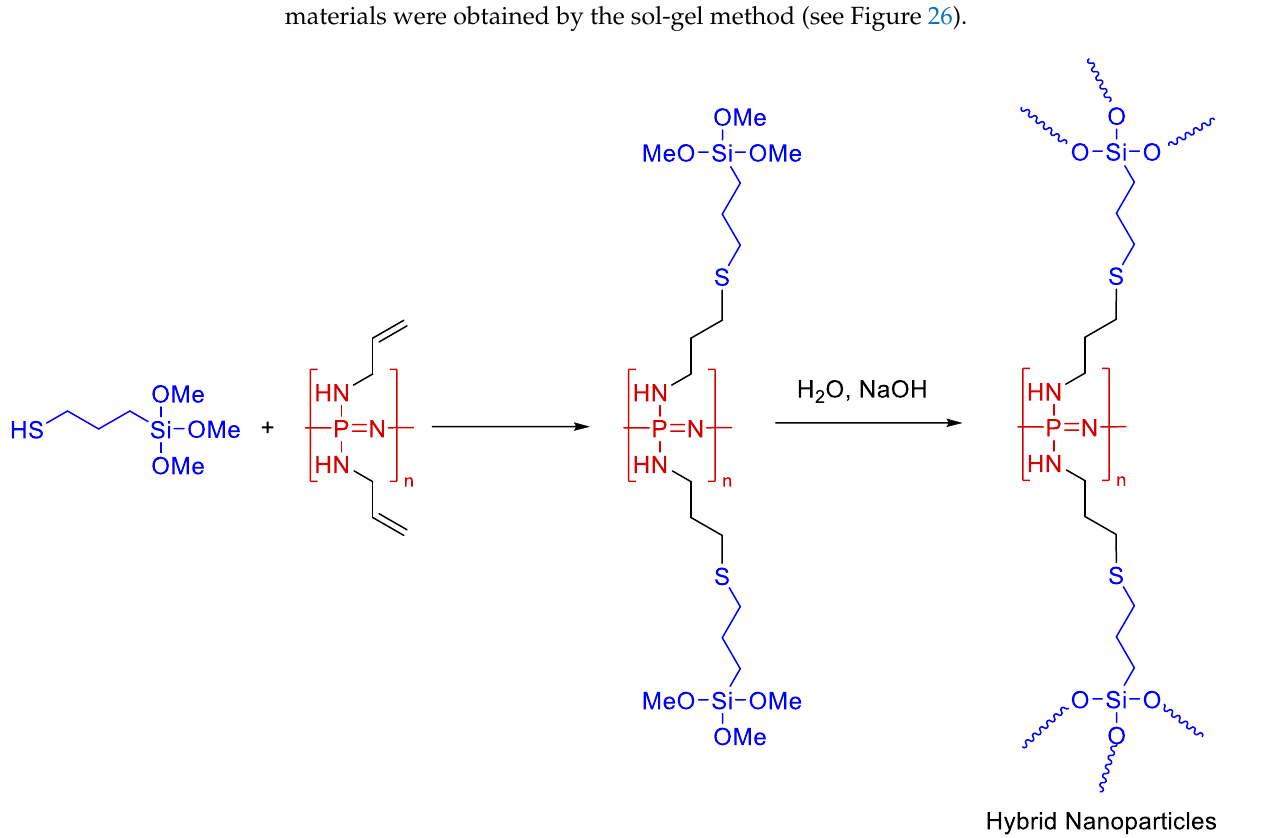
Figure 26. The synthetic procedure for the silica-based hybrid nanoparticles preparation using linear linear trimethoxysilane with phosphazene backbone precursor. Reprinted/adapted with permission from Ref. [114].